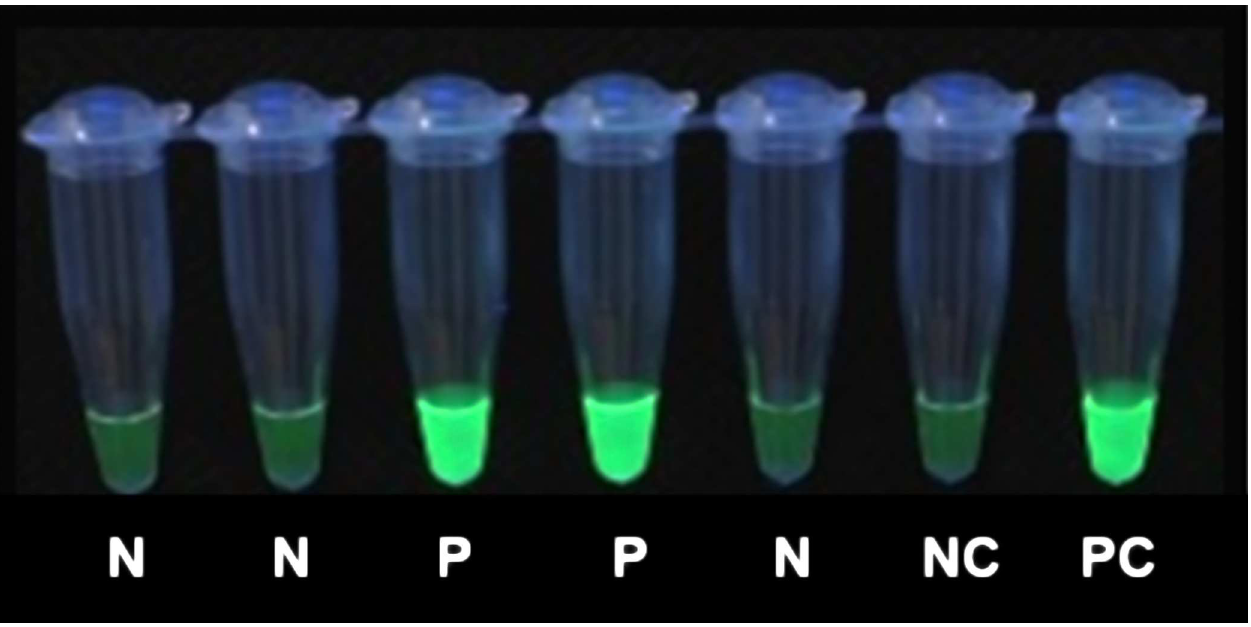
Fig 1. Detection of LAMP result under UV light. N- negative,P- positive, NC-negativecontrol, PC- positive control.